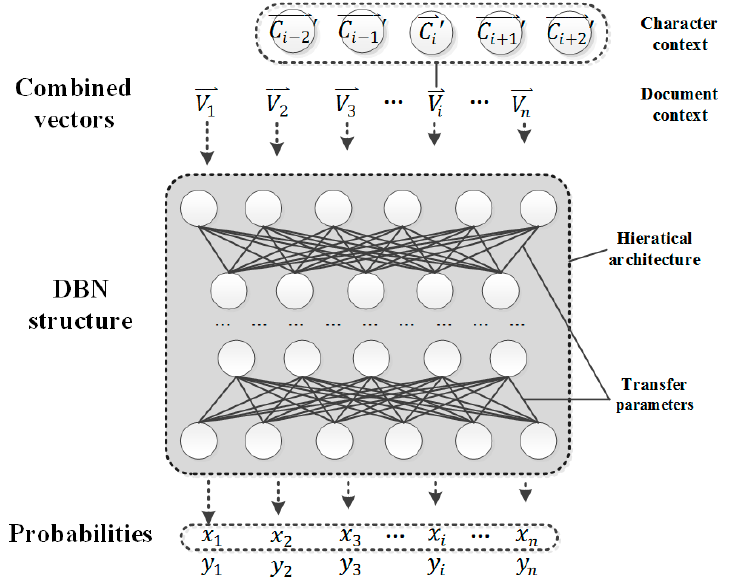
(cid:48) (cid:42) C i represents the binary